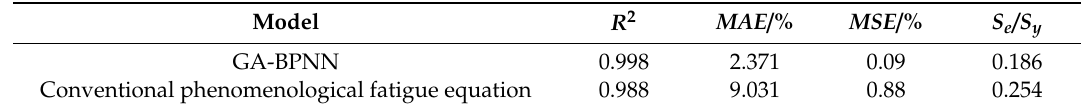
Table 11. Comparison of model prediction e ff